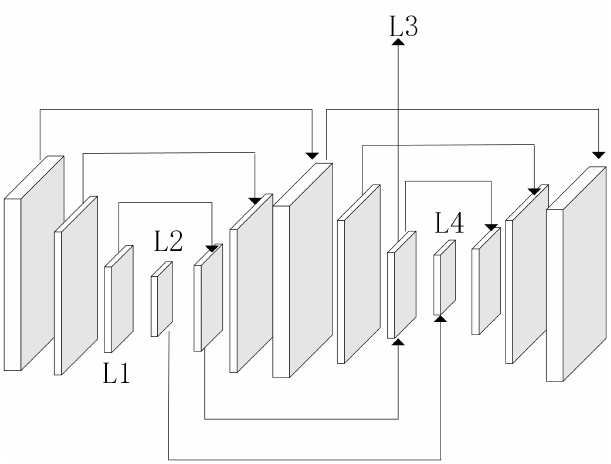
Figure 2. The feature fusion structure in AANet+, in which L1, L2, L3 and L4 are deformable convolutions and the rest are standard 2D